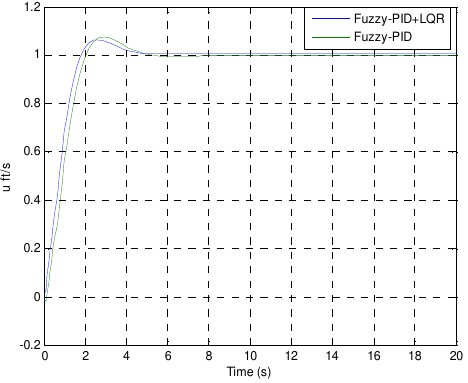
Fig . 13. Airspeed due to both controllers